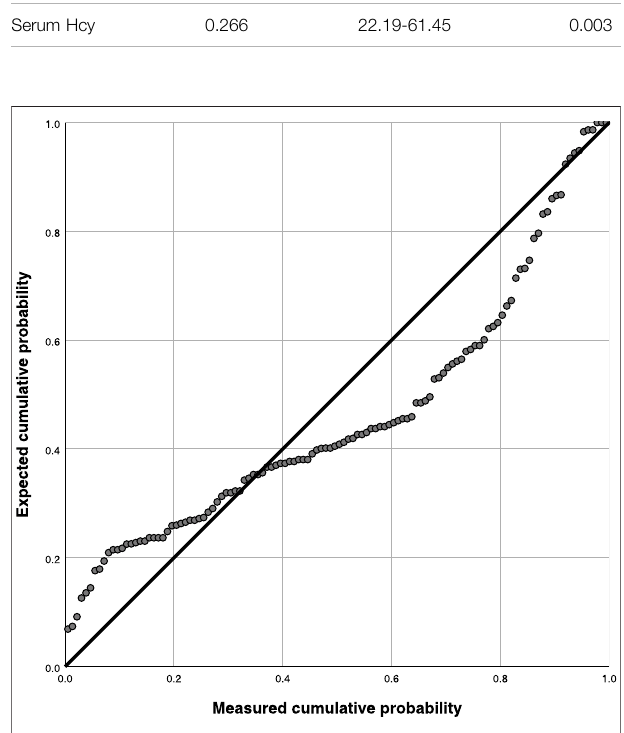
FIGURE 3 | Logistic regression analysis of serum Hcy level and the severity of in stent restenosis.